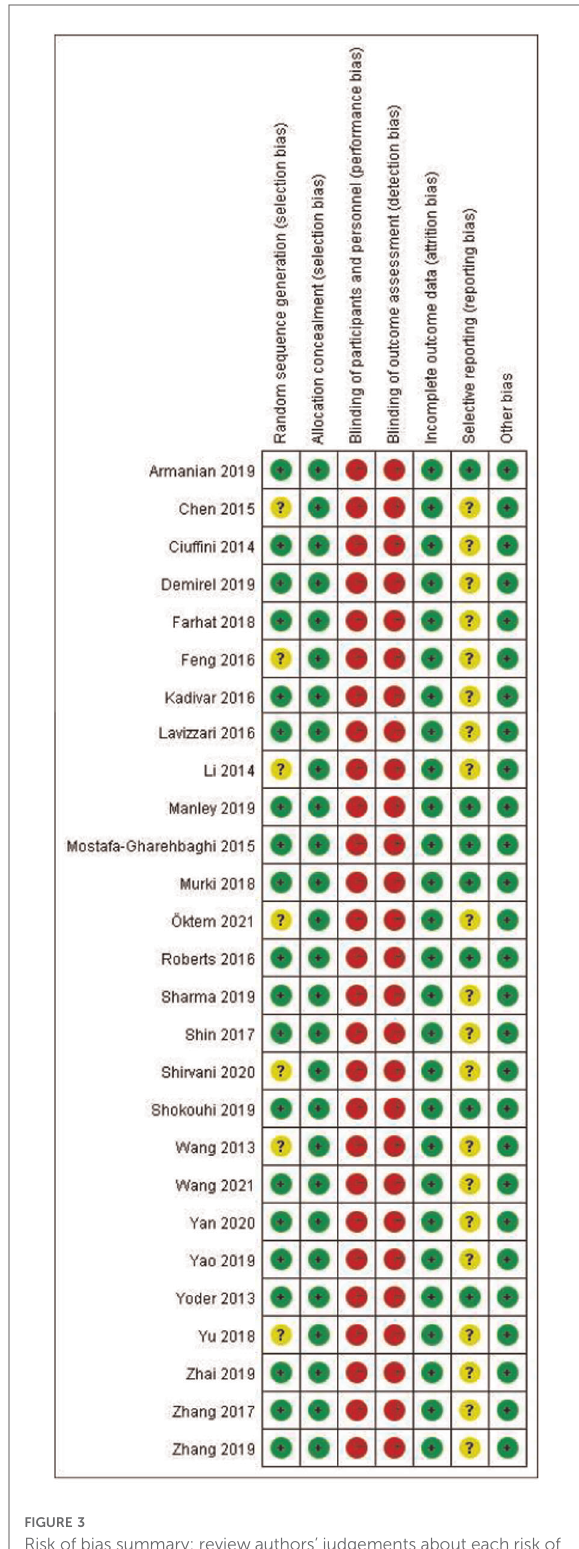
FIGURE 3 Risk of bias summary: review authors ’ judgements about each risk of bias item for each included